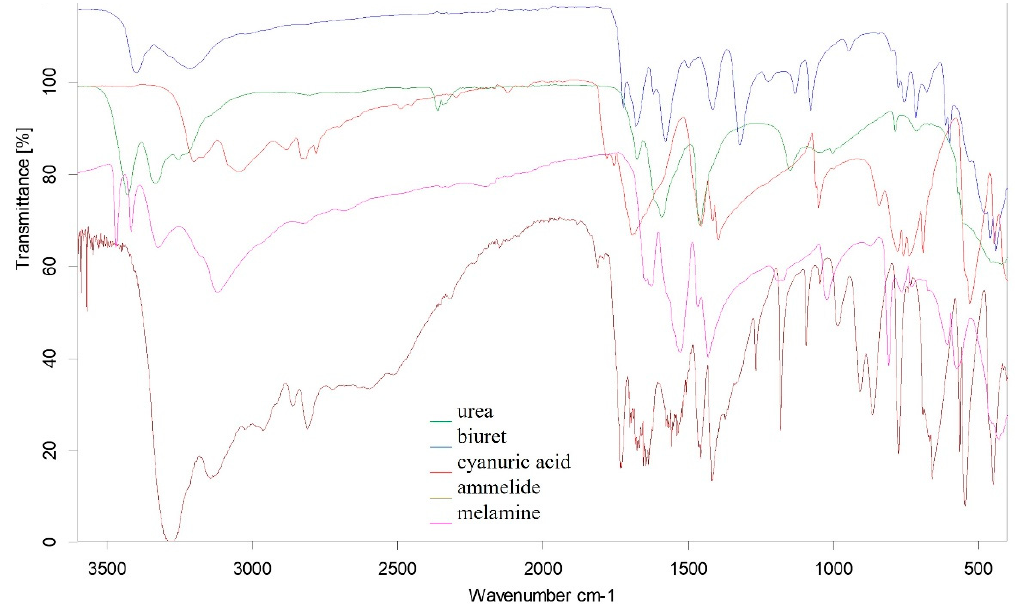
Figure 10. FTIR spectra of reference materials.